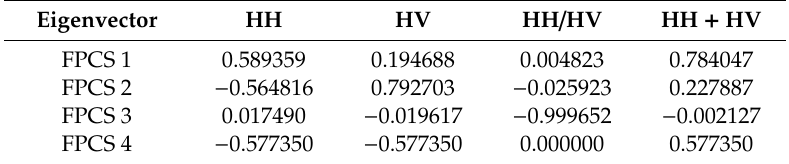
Table2. Eigenvectormatrixofcopolarizedandcross-polarizedbackscatteringforPALSARFPCSimages. Eigenvector HH HV HH / HV HH + HV FPCS 1